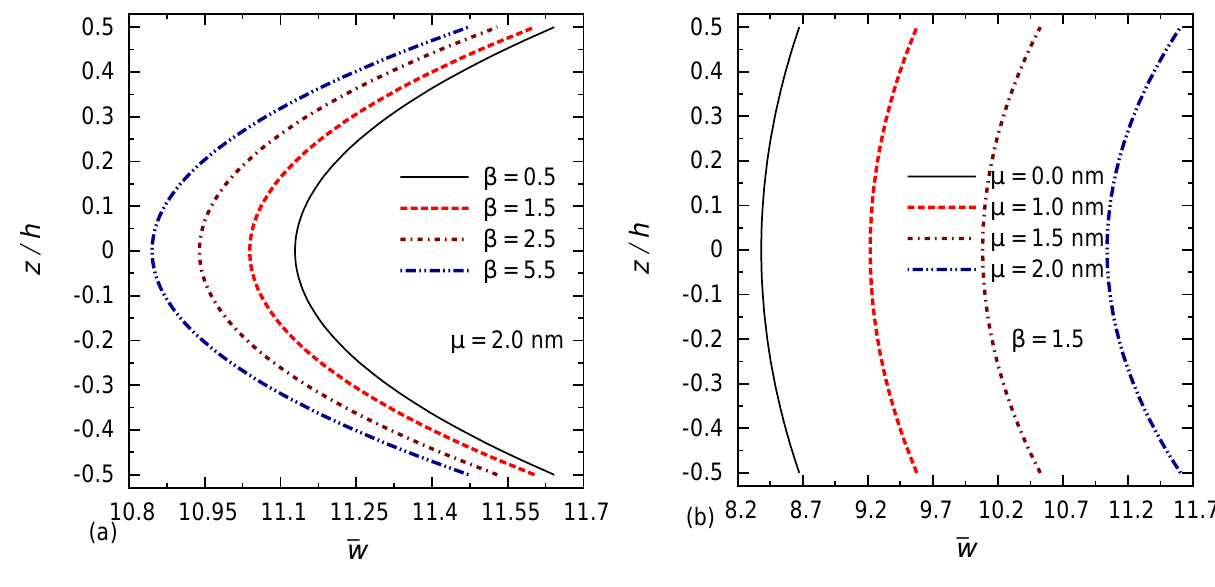
Figure 3. Effects of ( a ) FG parameter β and ( b ) nonlocal coefficient µ on the deflection ¯ w through- the-thickness of the FG square nanoplates embedded in an elastic medium ( a = 10 h , t 2 = t 3 = 200, κ 1 = κ 2 = 10 ) .